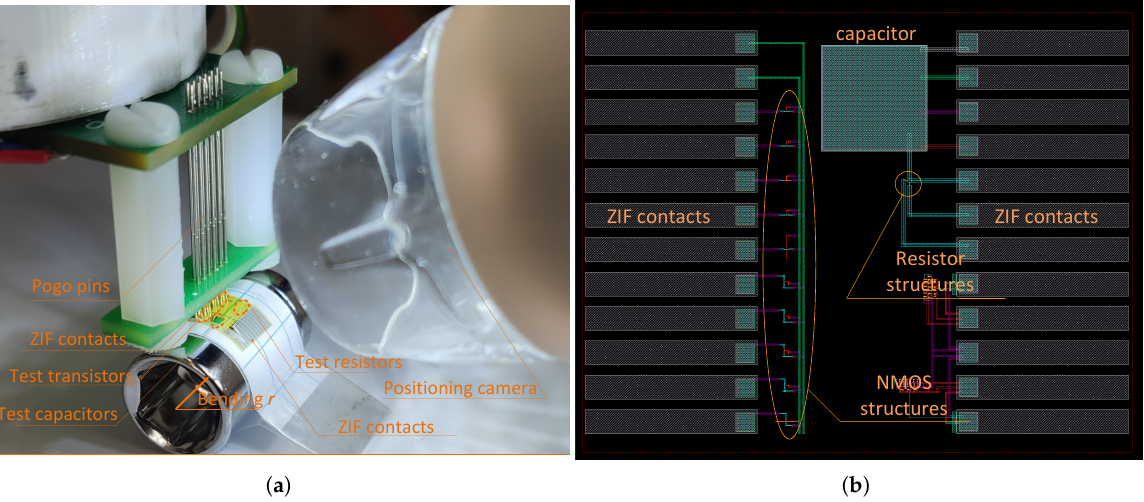
Figure 2. Test structure attached to a bending jig ( a ) and layout of the test structures (top view) ( b